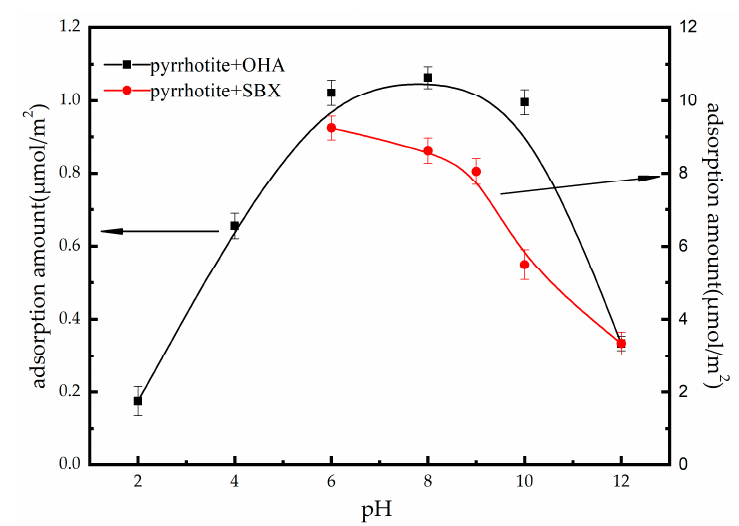
Figure 4. The adsorbed amount of the two collectors on the surfaces of pyrrhotite (ET = 24 h), as a function of pH values (octanohydroxamic acid (OHA) concentration: 1 × 10 − 4 mol/L, SBX concentration: 1 × 10 − 3 mol/L).